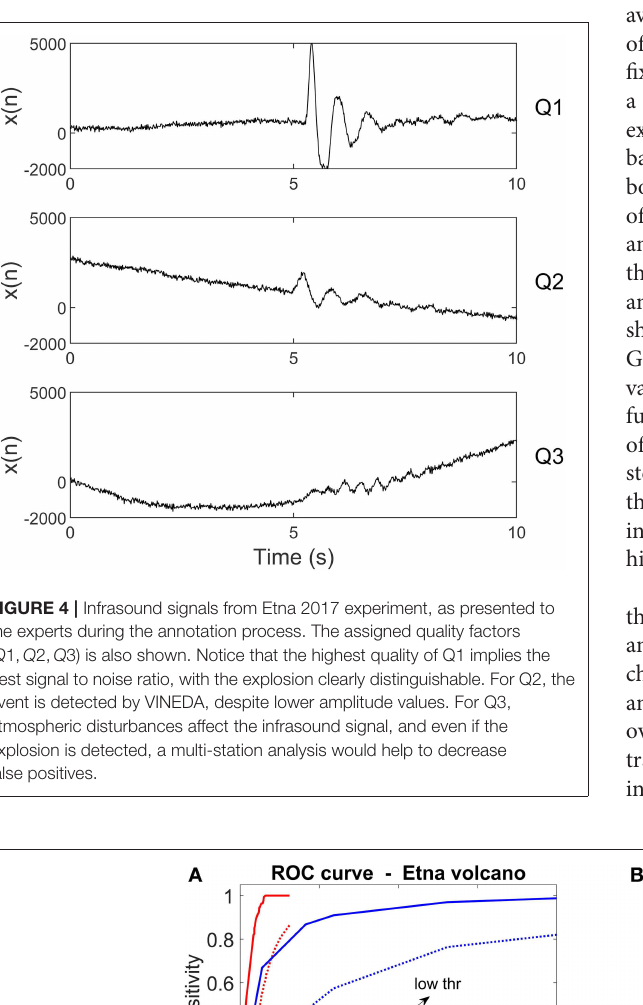
Frontiers in Earth Science |